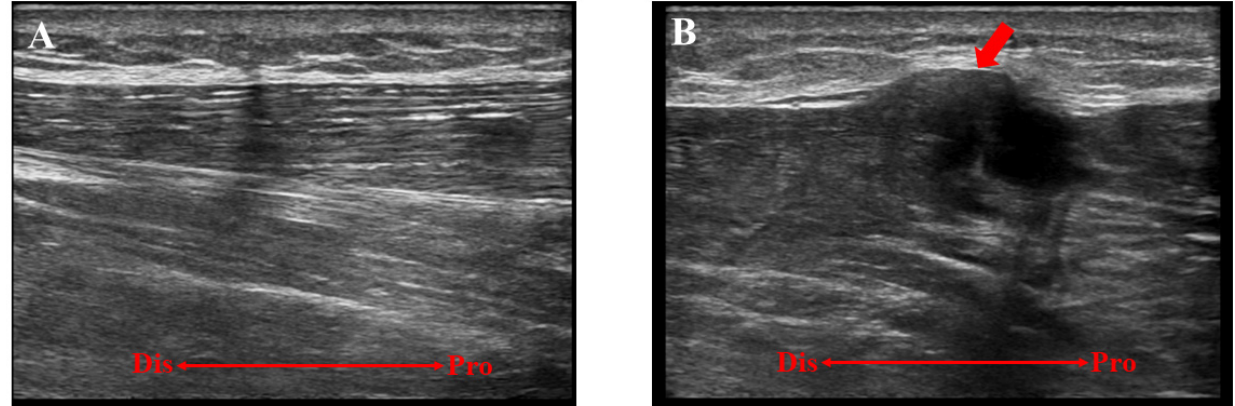
Figure 2. A preoperative ultrasonographic evaluation of the left lower extremity. ( A ) The lesion was not detectable with the patient in the supine position. ( B ) The lesion (red arrow) was swollen and detectable in the standing position after strenuous activity. Dis, distal; Pro, proximal.